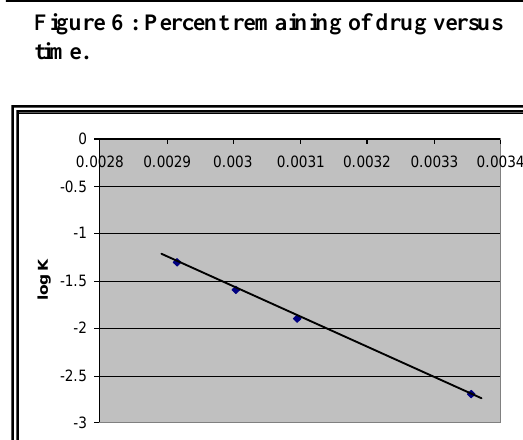
Figure 6 : Percent remaining of drug versus time.